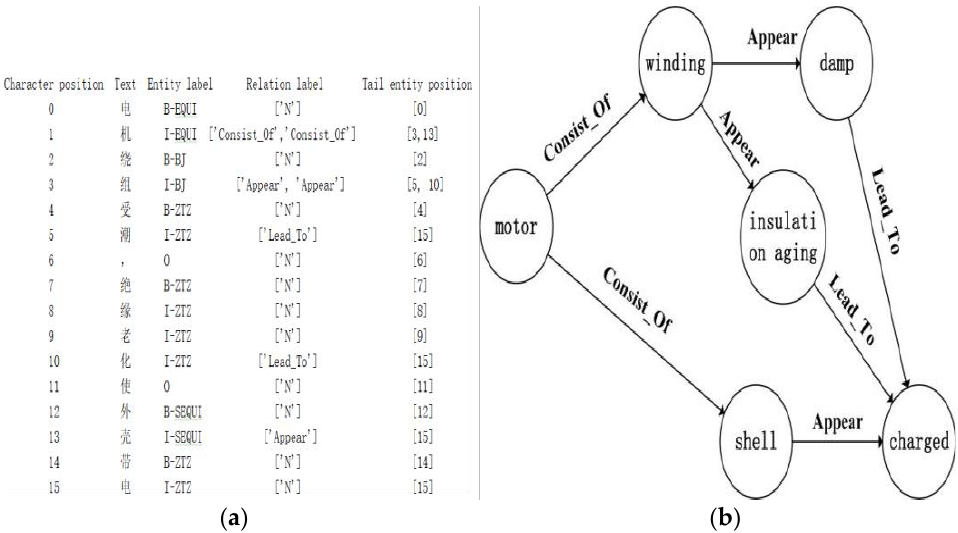
Figure 2. Example of argument entity and relation annotations and relation diagrams for sample sentences. The sentence in ( a ) means that the motor winding is affected with damp and the insulation aging makes the shell live. An entity follows the BIO pattern, in which B indicates the start of the entity, I indicates the middle of the entity, and O indicates none. A relationship is connected by an entity tail to another entity tail. ( b ) shows the entity relationship of the sentence in ( a ). It shows that the motor is composed of winding and shell. The shell is charged due to damp and insulation aging.